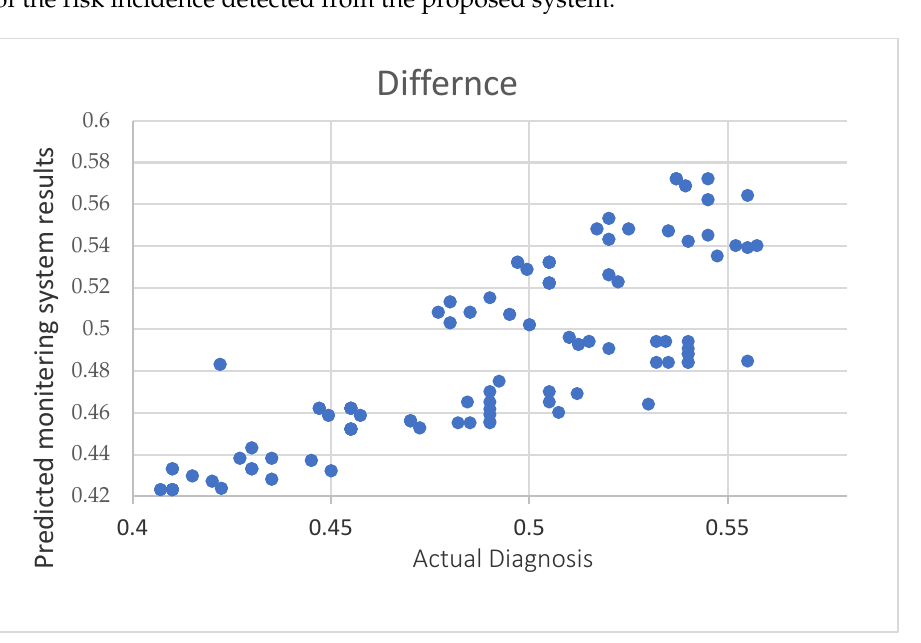
Figure 8. The Bland-Altman Plot that denotes the difference of the predicted values versus the av- erage of actual diagnoses. The true positive rates of health-related risk incidences used for the three used mod- els are depicted in Tables 5 and 6. In the SERV-112 dataset, the monitoring prediction method predicted by the DNN is comparatively balanced. The True positive rate in the DNN system with four hidden layers is above 80%, and the health-related risk incidences have a moderate recall rate. Compared with the system presented, long short-term memory is considerably enhanced in the proposed research, with a true positive rate as high as 92.8%. The other groups of health-related risk incidences have a reasonably bal- anced true positive rate (namely; fall, fall with broken bones, and fall that leads to death). Table 7 shows that other common health-related risk types have the highest true positive rate in the presented methods in the SV-S2017 dataset, except for falls that lead to death